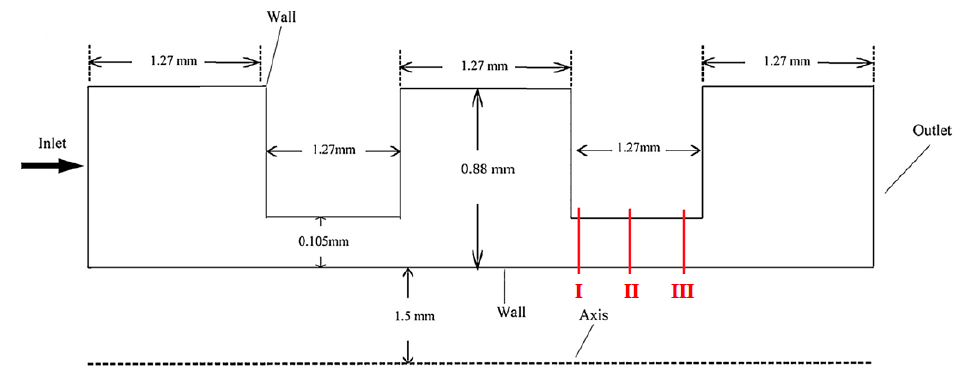
Figure 5. The structure of see-through labyrinth seal used in Yuan’s experiment. Table 1. The inlet & outlet boundary condition of numerical simulation.